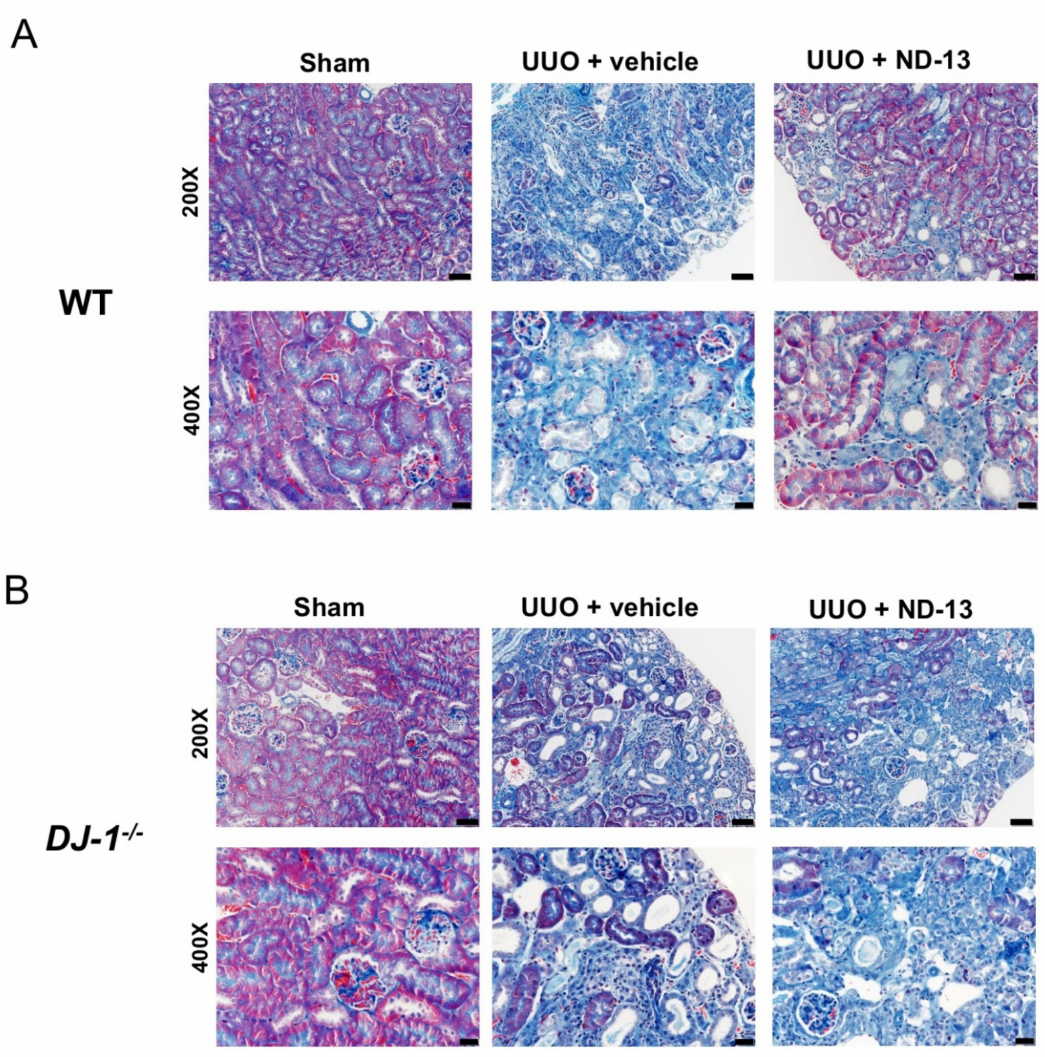
Figure 3. Treatment with ND-13 seems to blunt the spread of UUO-induced fibrosis accumulation in the cortex of WT mice but fails to do so in DJ-1 − / − mice. ( A ) Representative Masson’s blue trichrome images of renal cortex of WT mice that underwent sham surgery, UUO and vehicle treatment or UUO and ND-13 treatment: 200 × (upper panels; scale bar = 50 µ m) and 400 × magnification (bottom panels; scale bar = 20 µ m). ( B ) Representative Masson’s blue trichrome images of renal cortex of DJ-1 − / − mice that underwent sham surgery, UUO and vehicle treatment or UUO and ND-13 treatment: 200 × (upper panels; scale bar = 50 µ m) and 400 × magnification (bottom panels; scale bar = 20 µ